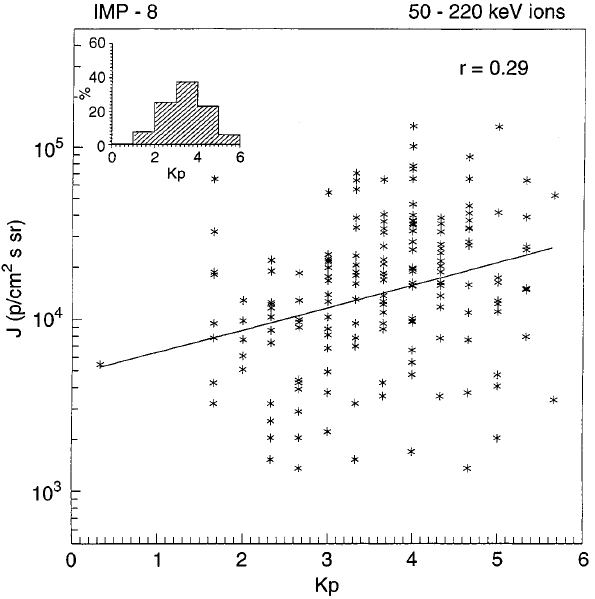
Fig. 4. The intensity of 50–220 keV ion events of magnetospheric origin as a function of the index of geomagnetic activity K values of K found during the upstream events are consistent with the p initial assumption of their magnetospheric